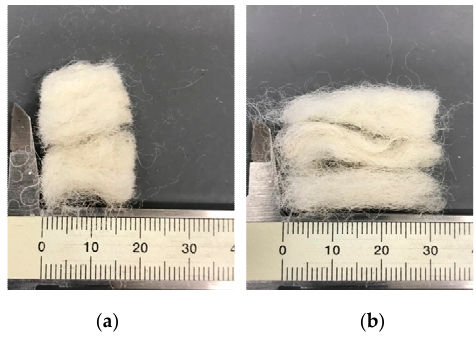
Figure 1. Sheep wool fiber used: ( a ) 1.5 cm long ( b ) 3.0 cm long.